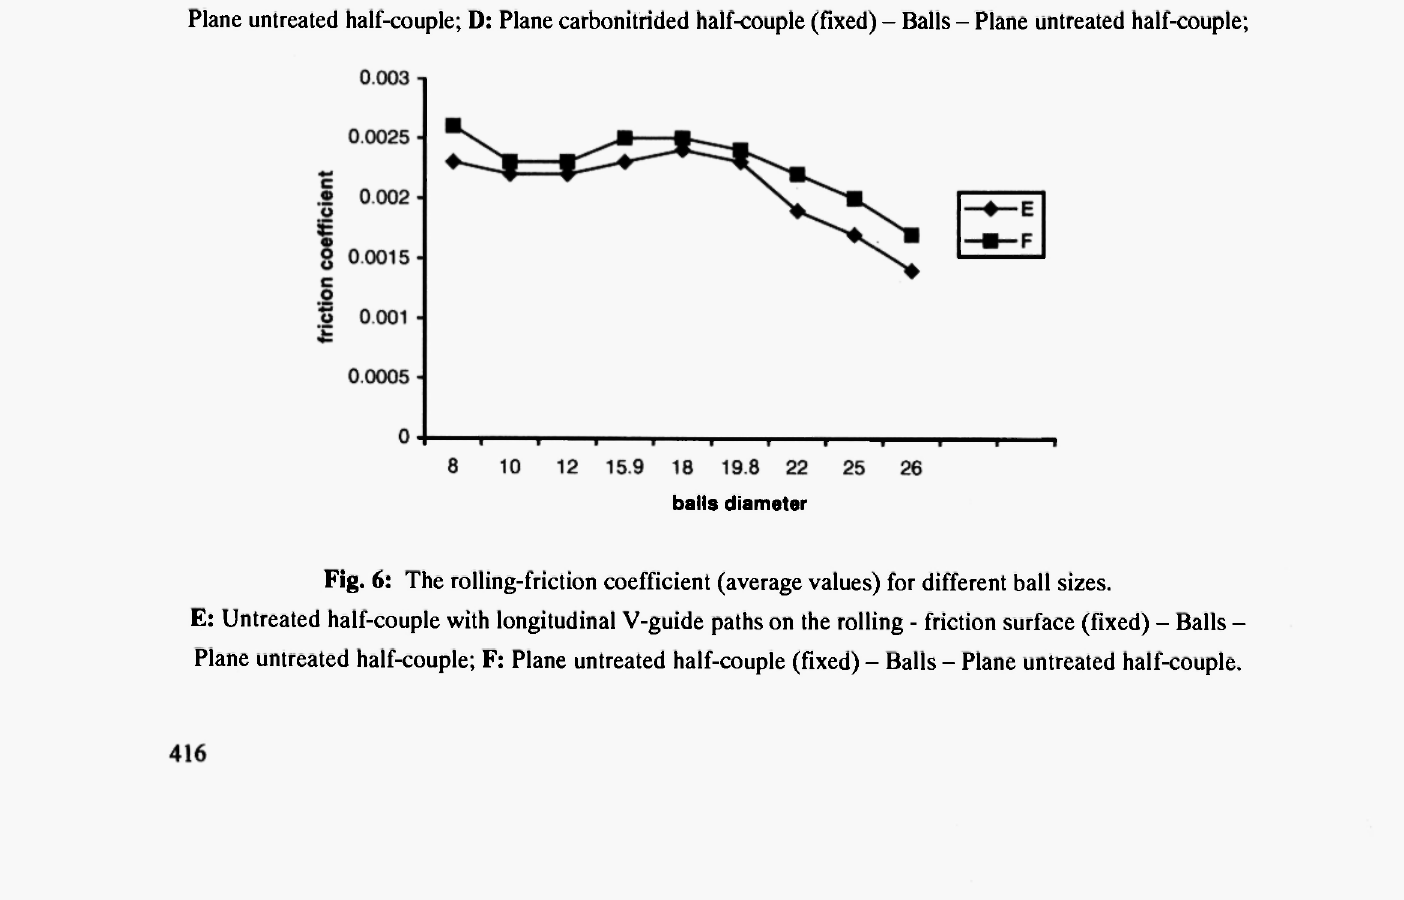
Fig. 6: The rolling-friction coefficient (average values) for different ball sizes. E: Untreated half-couple with longitudinal V-guide paths on the rolling - friction surface (fixed) - Balls - Plane untreated half-couple; F: Plane untreated half-couple (fixed) - Balls - Plane untreated